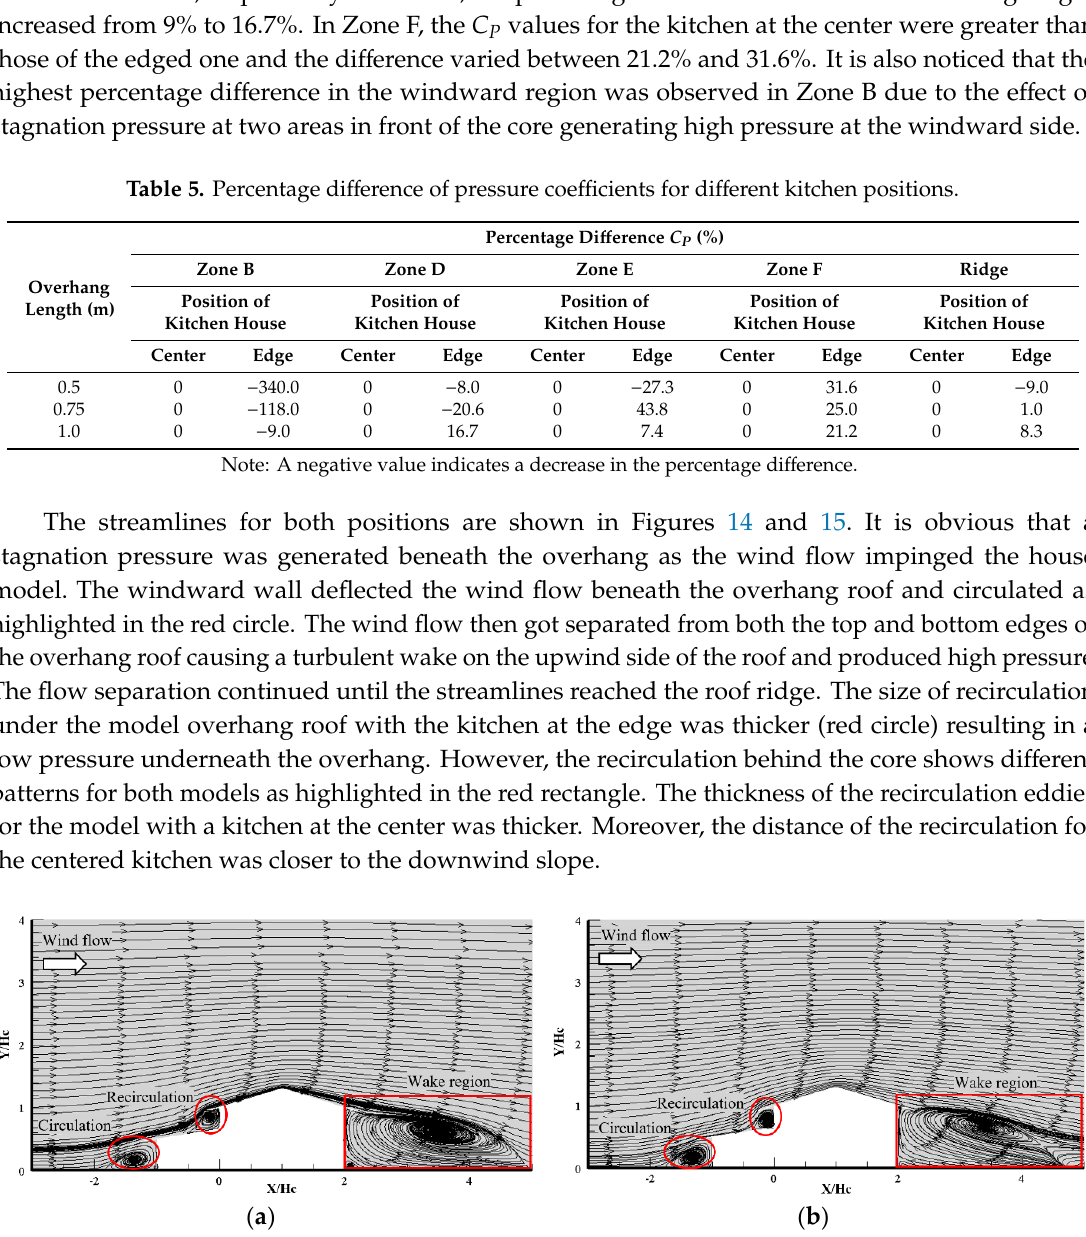
Figure 14. The streamlines for the model with kitchen at the ( a ) center and ( b ) edge.